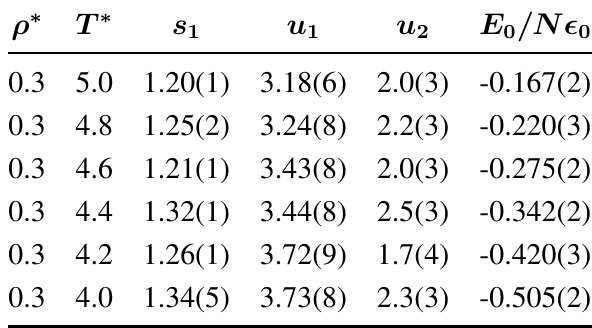
Table 1. Coefficients appearing in the Landau–de Gennes free energy Equation (14) and the mean internal energy Equation (12) for the model parameters used in [30]. Numbers in brackets denote the uncertainty in the last digit.